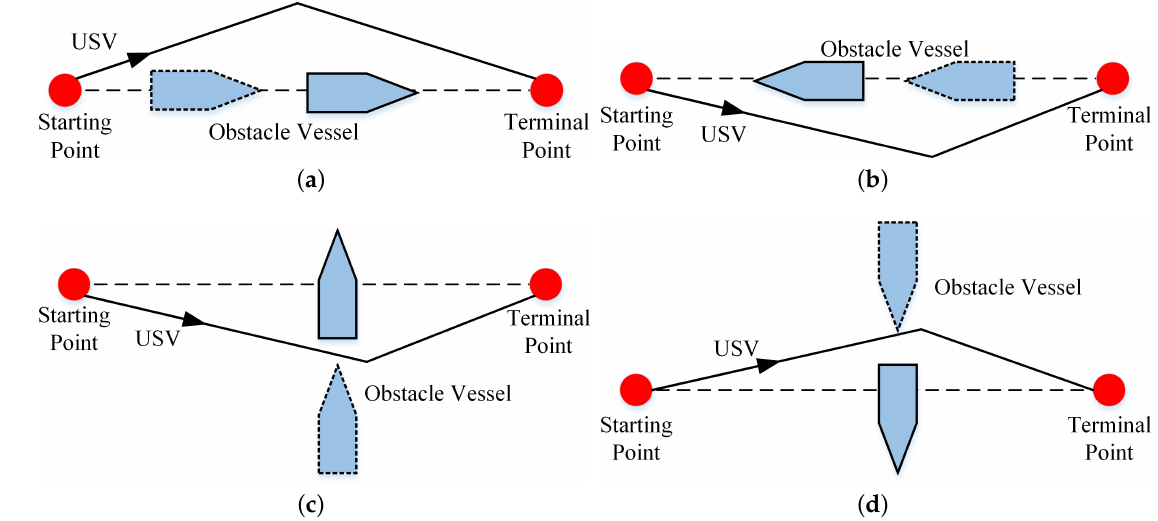
Figure 5. Rule diagram of collision avoidance. ( a ) Overtaking situation; ( b ) Head-on situation; ( c ) Crossing situation on the starboard side of USV; ( d ) Crossing situation on the port side of